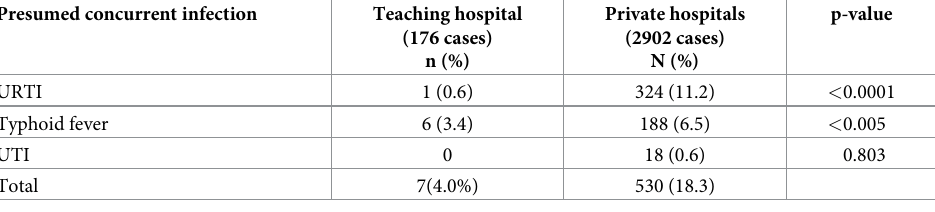
Table 2. DVI with presumed concurrent bacterial infection.